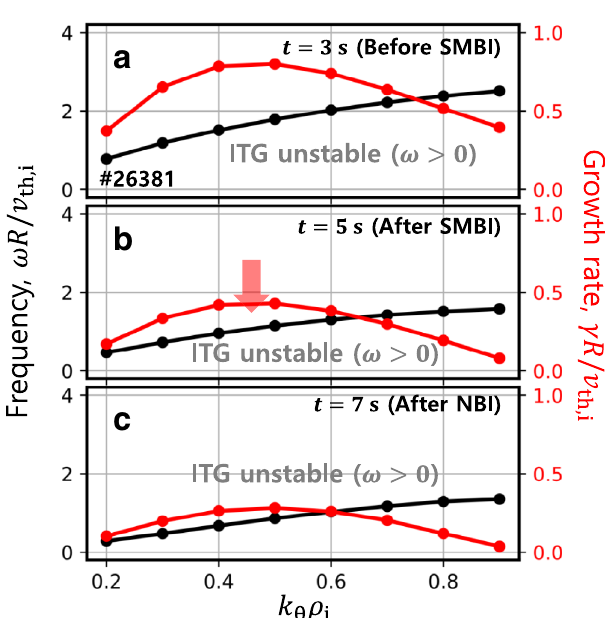
thecurrentdensity( j sum )at t =3s ( d ),5s ( e ),and7s ( f ).Currentdensitypro fi lesby MSE-constrainedEFIT( j MSE (cid:2) EFIT )arealsoshownforcomparison.Theabscissaisthe normalizedtoroidalmagnetic fl ux, ρ N .Theanomalouscurrent( δ j )isindicatedwith the shade.